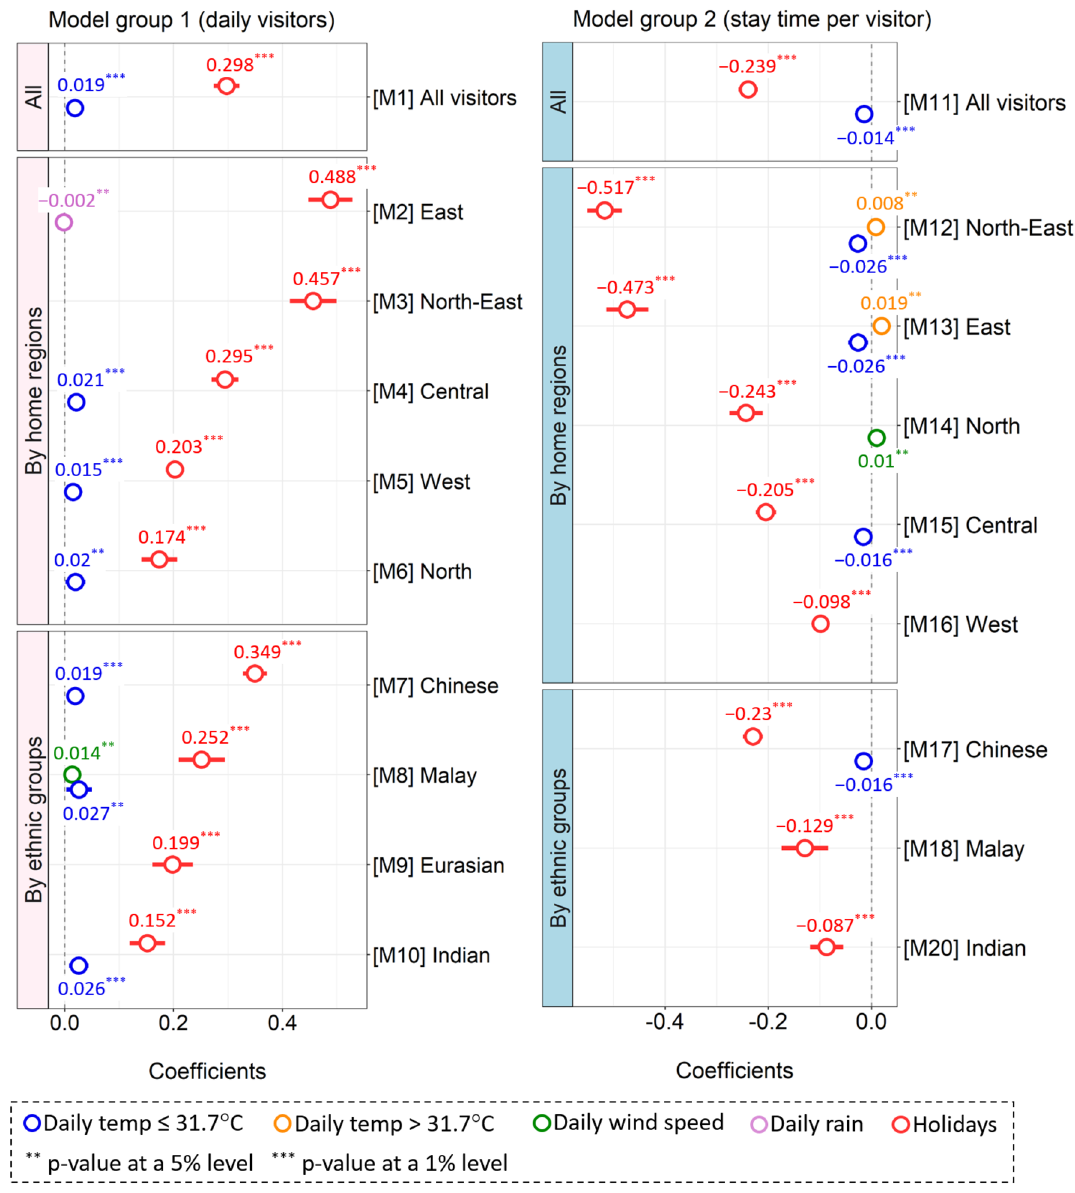
Figure 3. Results of the generalized linear mixed-effects models. Group 1 (M1 to M10) analyzes daily total visitors to the urban protected area. Group 2 (M11 to M20) analyzes stay time per visitor (minutes) in the urban protected